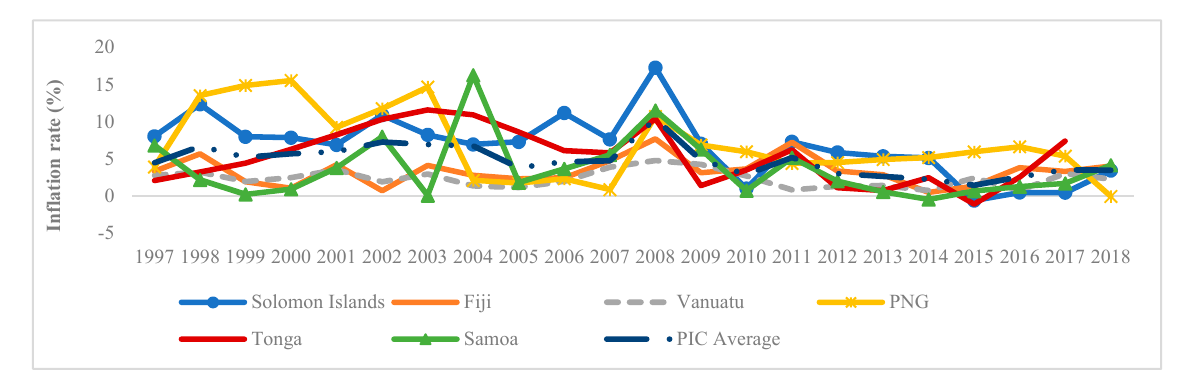
Figure 2. Annual rates of inflation in PICs, 1997–2018. Data from WorldData.info. (WorldData.info 2020a, 2020b, 2020c,